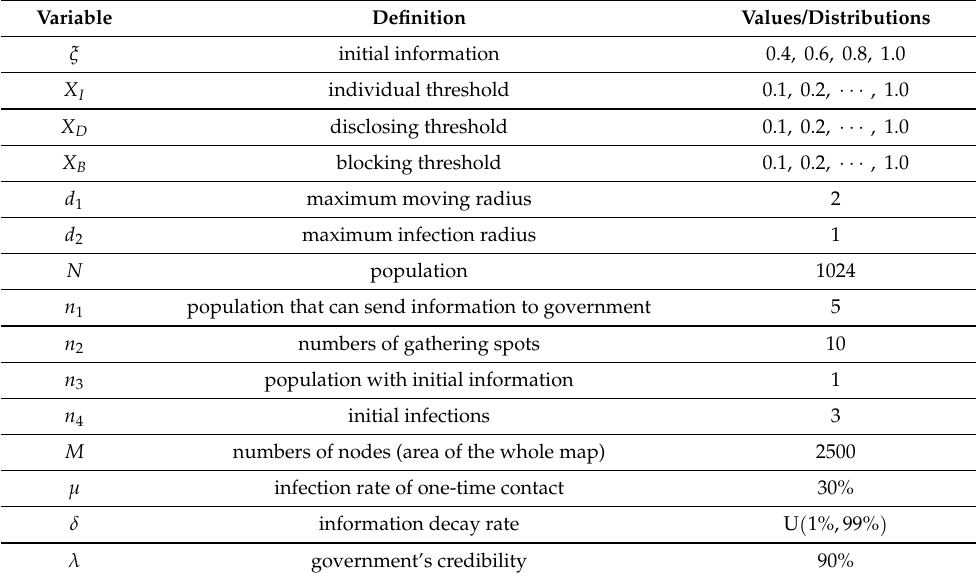
Table 1 lists the definitions, values, and distributions of all parameters in the model. Table 1. Definitions, values, and distributions of variables in the